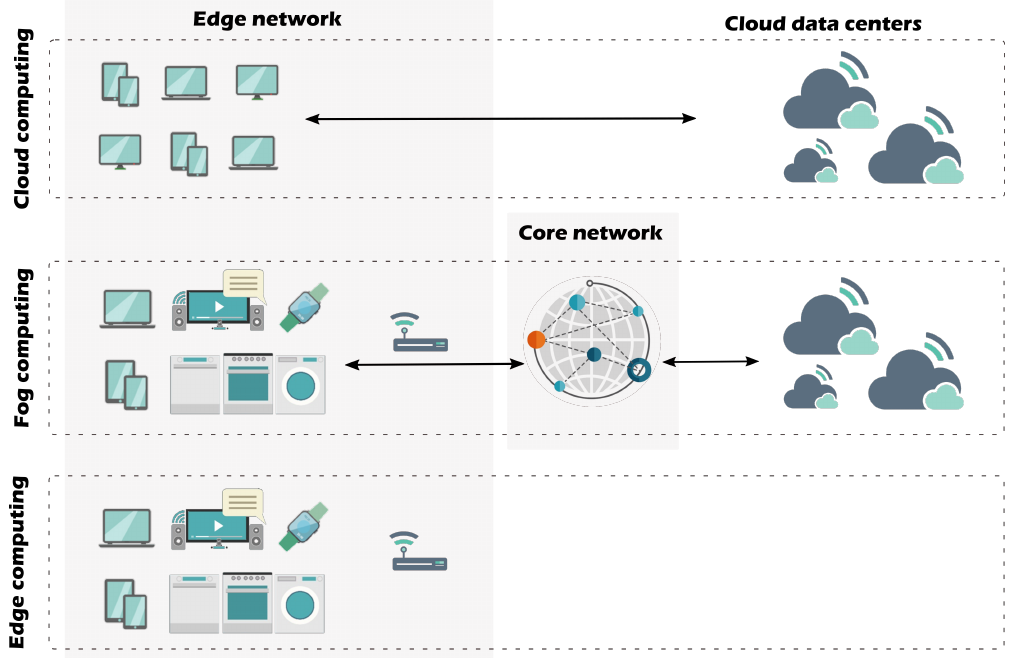
Figure 1. Cloud, fog and edge domains (based on Mahmud et al.